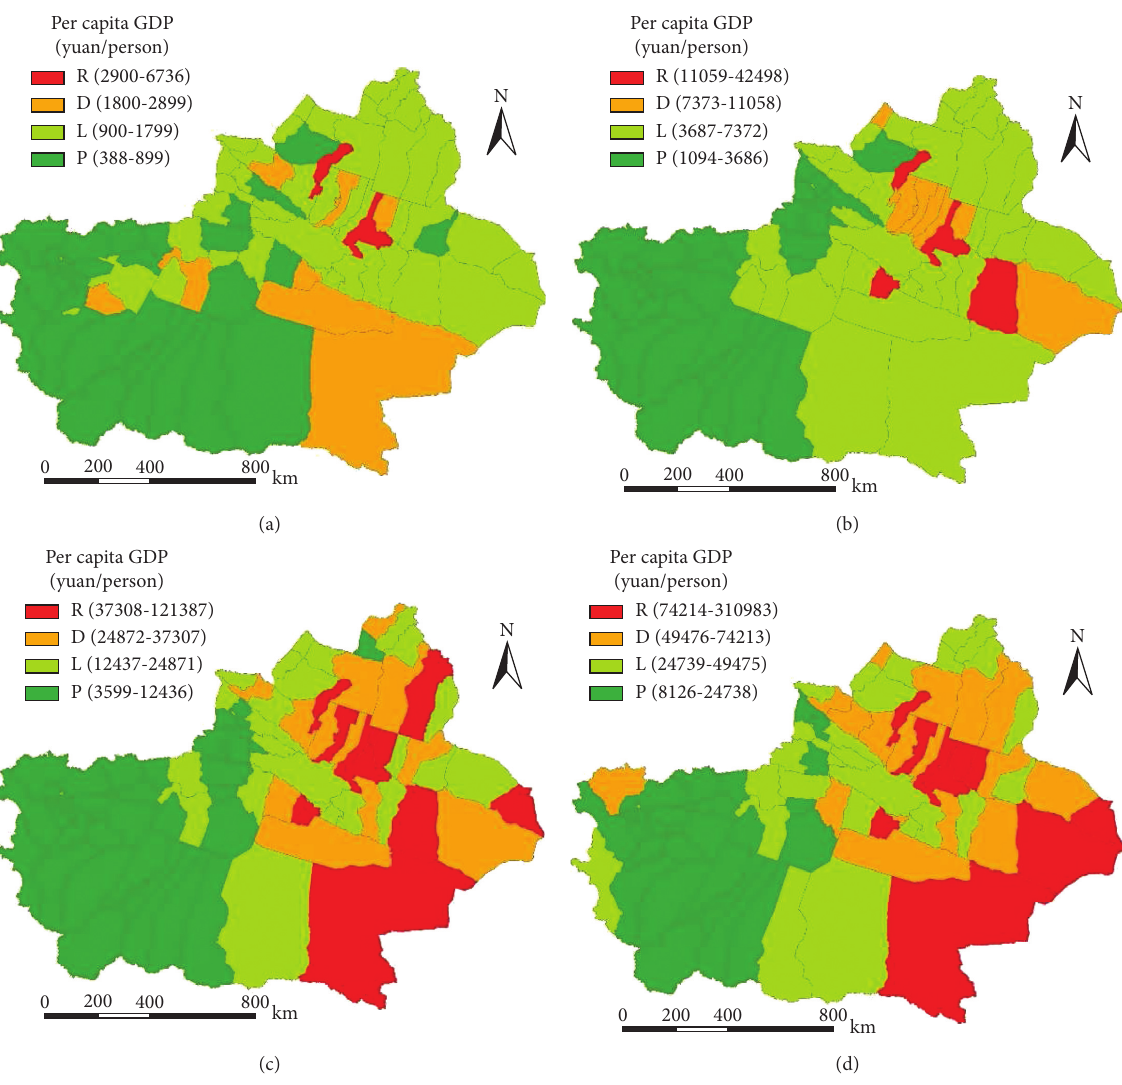
Figure 3: Spatial patterns of per capita GDP in Xinjiang, 1990–2018: (a) 1990; (b) 2000; (c) 2010; (d) 2018. P:poor, L:less developed, D: developed, R: rich.